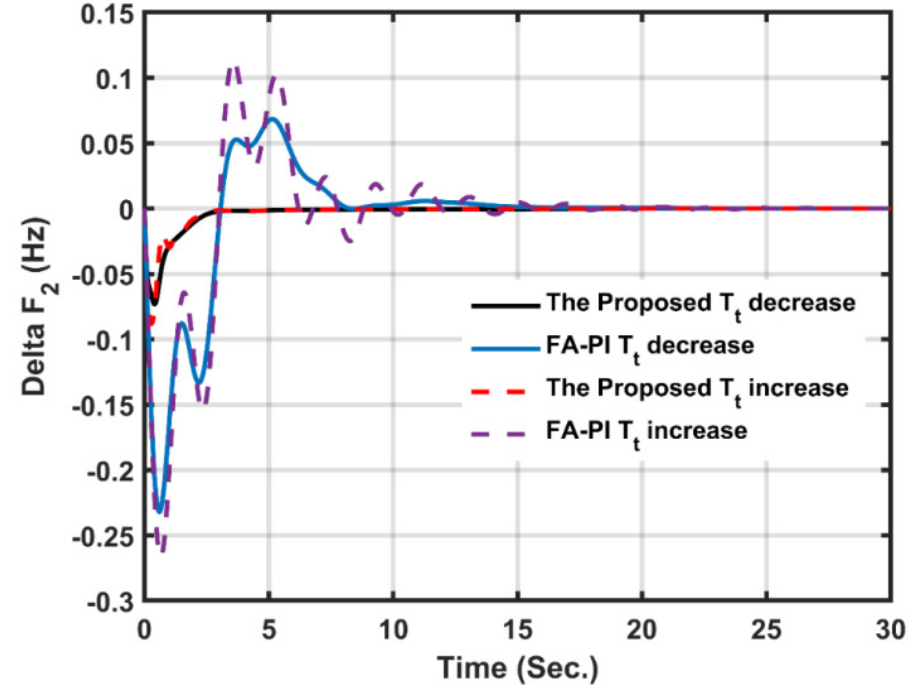
Figure 26. Frequency deviation in area 2 under T t changes.